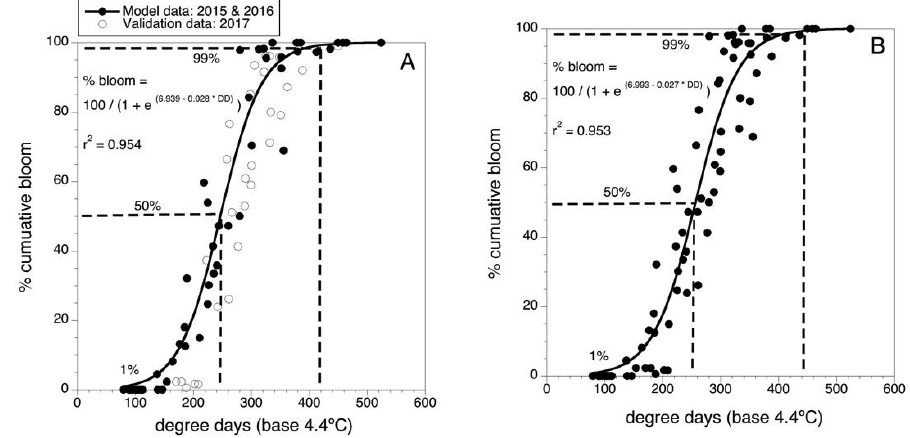
Figure 2. Degree-day predictive model for Maine wild blueberry cumulative bloom. ( A ) Initial model and validation, model building data are solid round black data points, n = 26 fields. Overlaid validation data are non-filled round data points, n = 7 fields. ( B ) Final model with all 33 data points (2015–2017). Dashed lines are 50 and 99 predicted percentile levels of bloom.